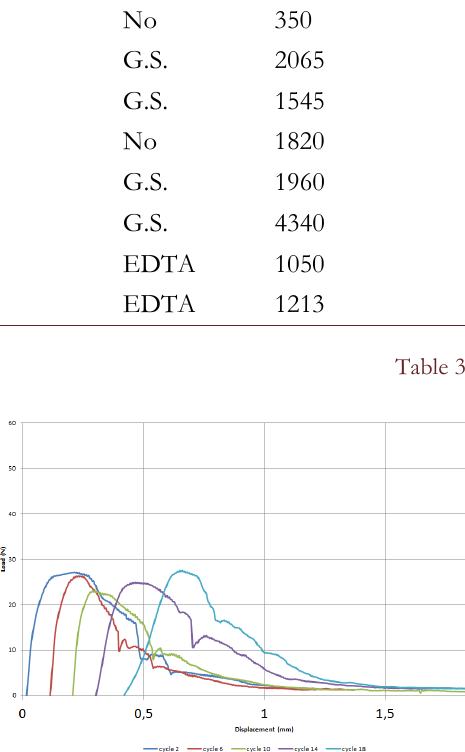
Figure 7: Load vs displacements plot of the extraction test carried out with gel lubricant.